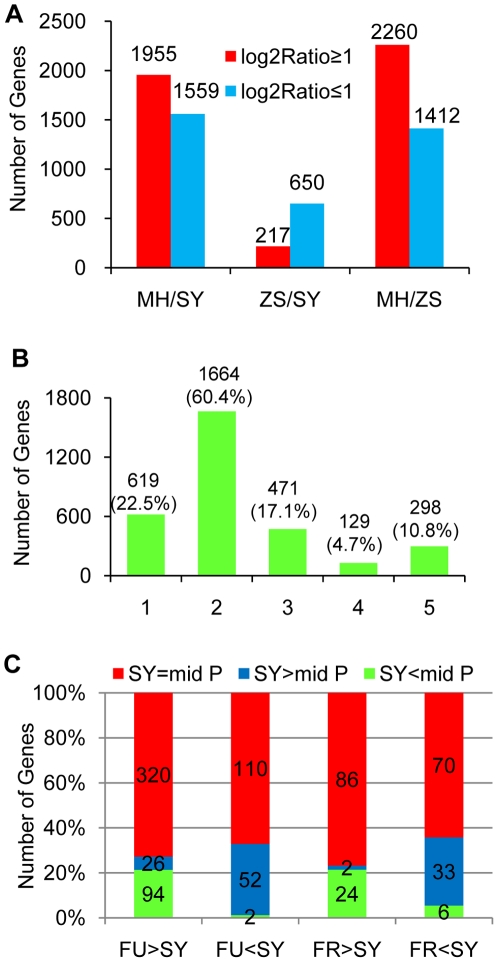
Differential gene expression patterns in hybrid SY63.(A). Numbers of differentially expressed genes (FDR≤0.001 and |log2Ratio|≥1) in MH63 versus SY63, ZS97 versus SY63 and MH63 versus ZS97. Black bars: up-regulated genes; grey bars, down-regulated genes. (B). Numbers of differentially expressed gene in SY63 compared to mid-parent (|log2Ratio|≥1). 1, SY<mid-parent; 2, SY = mid-parent; 3, SY>mid-parent; 4, SY<low-parent; 5, SY>high-parent. (C). Percentage of nonadditive and additive gene in SY63 affected by OsHDT1 over-expression (FU) and RNAi (FR).